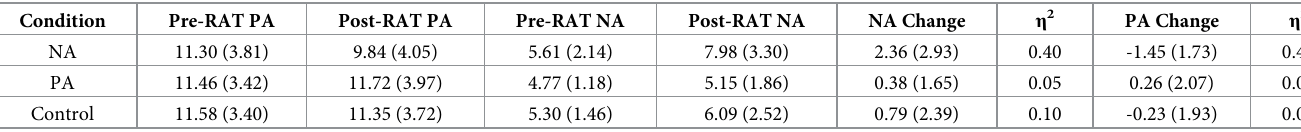
Manipulation check Table 3 depicts the PA and NA pre-RAT and post-RAT mood ratings (mean, SD) across con- ditions. Consistent with expectations, there was a significant main effect of time on both NA and PA for the NA condition, F (1,43)=28.71, p < .001 and F (1,43)=31.05, p < .001, respectively, such that NA significantly increased, and PA significantly decreased, from pre- to post-RAT. Contrary to expectations, there was no change in PA from pre- to post-RAT in the PA condi- tion, F (1,38)=0.60, p =0.45, nor was there a change in NA, F (1,38)=2.12, p =0.15. Also unexpect- edly, there was a significant main effect of time on NA for the control condition, F (1,42)=4.72, p =0.04, such that NA significantly increased from pre- to post-RAT, though there was no change in PA, F (1,42)=0.63, p =0.43. Further analyses demonstrated potential differences between conditions on initial (i.e., pre- RAT) NA ( F (2,123)=2.72, p =0.07), but not pre-RAT PA ( F (2,123)=0.07, p =0.93). Post-hoc multiple comparisons revealed that the NA condition had greater pre-RAT NA than the PA condition ( p =0.02) but not the control condition ( p =0.38), while the PA and control condi- tions did not differ from each other on pre-RAT NA ( p =0.15). Because of this significant base- line difference, an ANCOVA comparing post-RAT NA was run, controlling for pre-RAT NA across conditions. As shown in Table 4, results were statistically significant. Consistent with expectations, post hoc multiple comparisons revealed that, controlling for pre-RAT affect, post-RAT NA was significantly greater in the NA condition compared to both the PA and con- trol conditions, and did not significantly differ across the PA and control conditions. Table 3. Mood ratings (mean, SD) across time points and conditions. Condition Pre-RAT